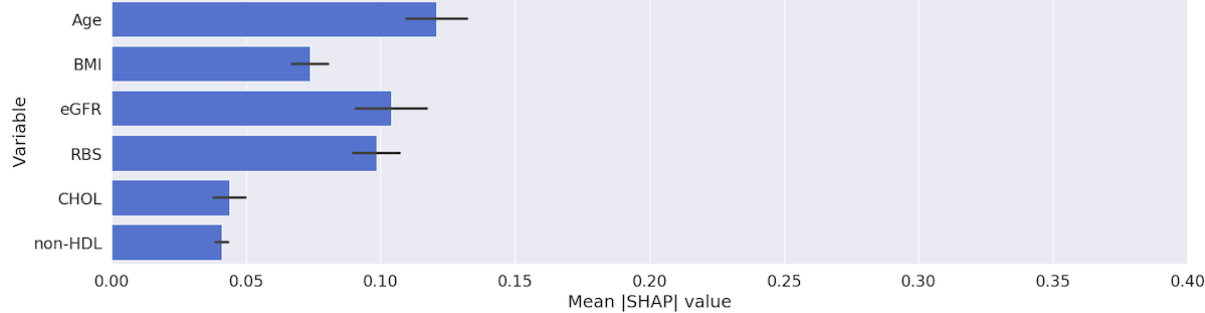
The task of predicting HbA